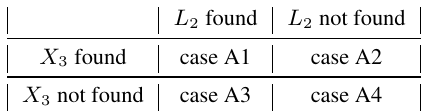
A1 L 2 detected (known geometry after applying of geometric algorithm on laserscanner data), X 3 detected (known